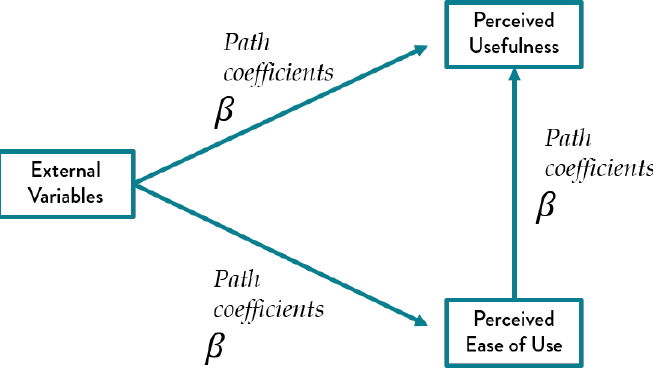
Figure 5. Path Coefficients.